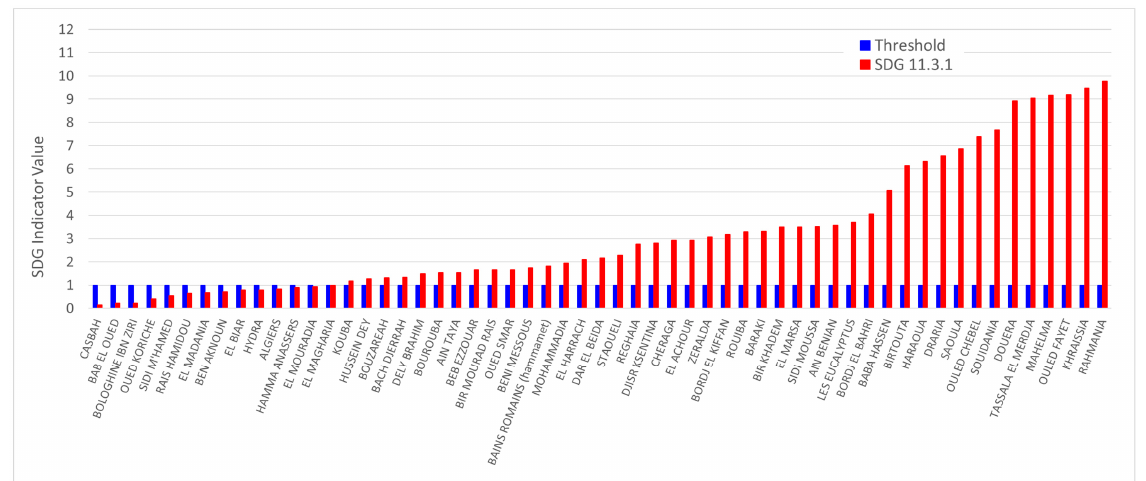
Figure 14. SDG 11.3.1 indicator values for the communes in the Algiers wilaya. The constant blue bars represent the value over which the commune develops away from sustainability.